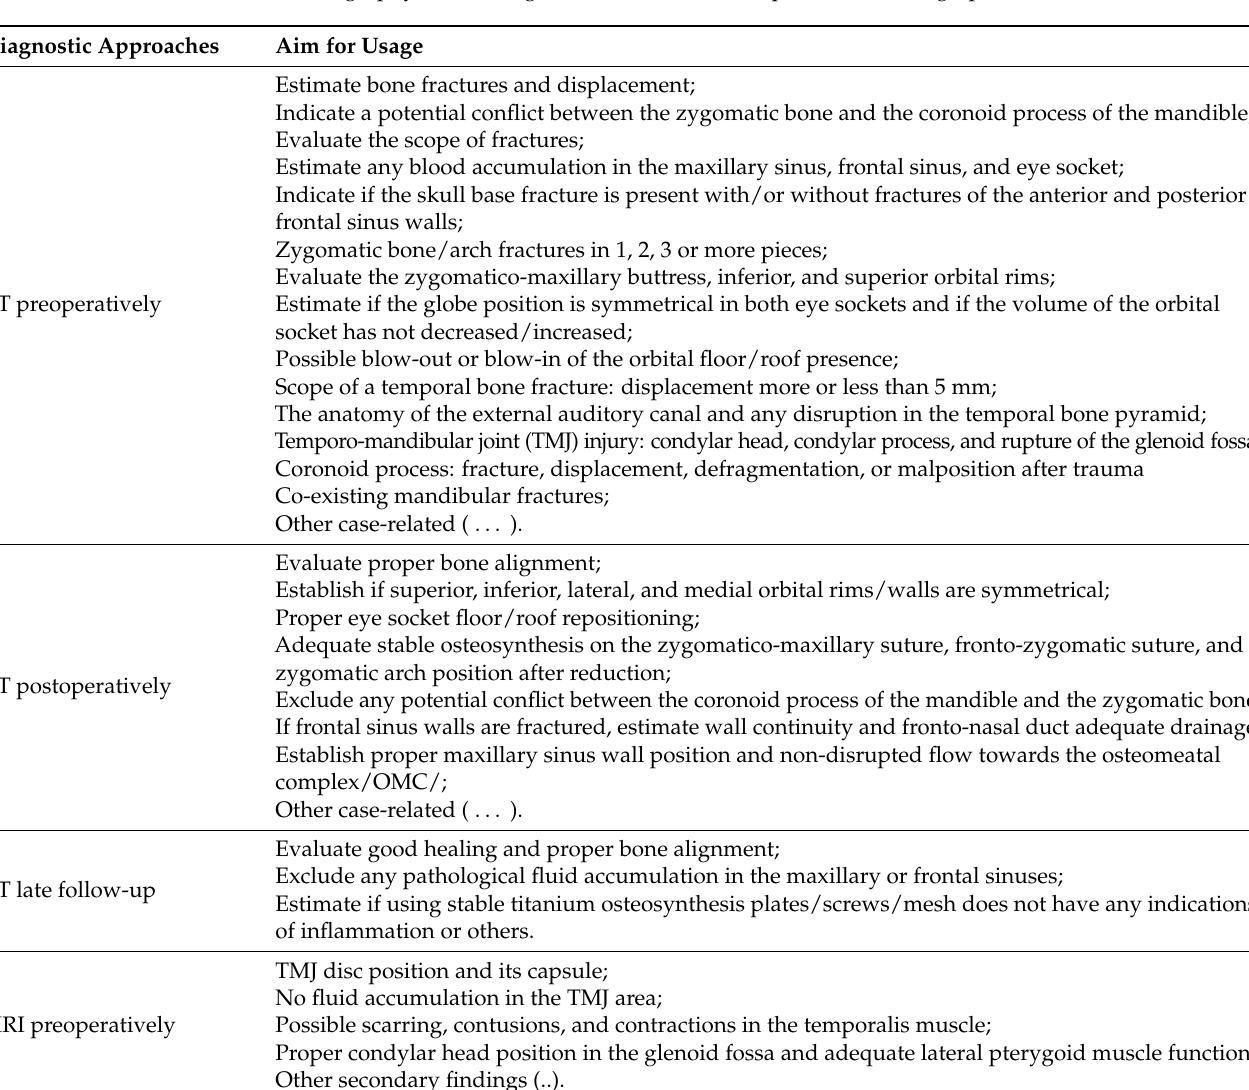
Table 1. The scope of diagnostic procedures suggested by the authors. Abbreviations: CT—computed tomography; MRI—magnetic resonance, Panx—panoramic